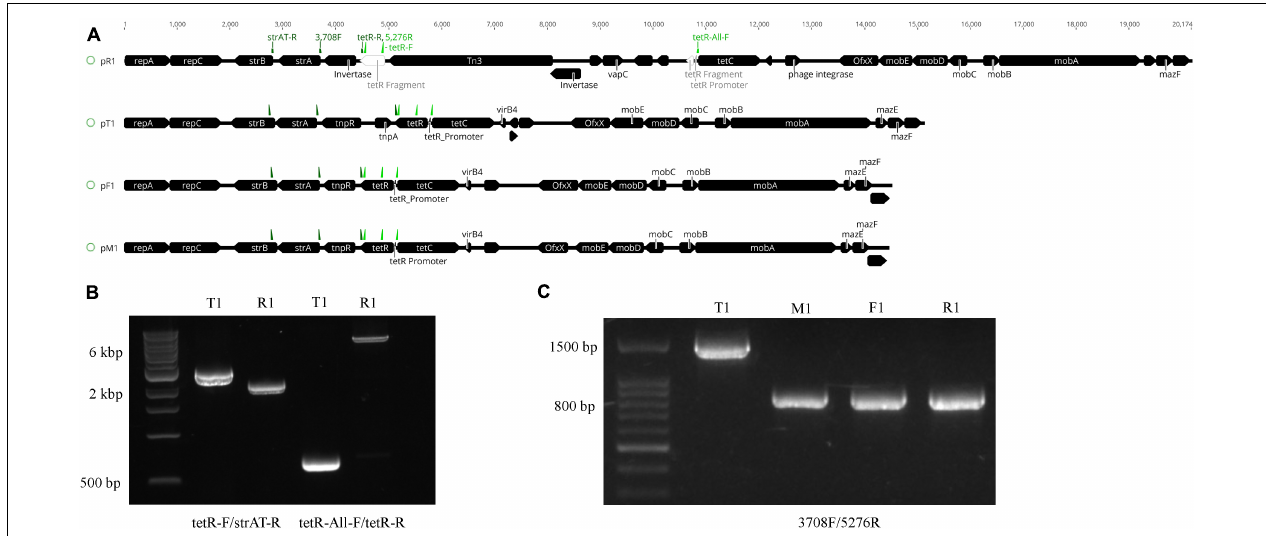
FIGURE 3 | Structural variations of the plasmids harboring the oxytetracycline (OTC) and streptomycin (STR) resistance genes in Xanthomonas arboricola pv. pruni . (A) Linear plasmid map of the de novo assembled plasmids harboring the tetracycline efflux gene tetC , the OTC transcriptional repressor tetR , and the streptomycin resistance operon strAB . The black boxes indicate genes with the points denoting their directions. tetR in strain R1 was physically separated into two parts, bases 1–136 and 137–639, via the Tn 3 insertion. On each plasmid, primers strAT-R, 3708F, and tetR-R were labeled as dark green arrows from left to right, and primers tetR-F, 5276R, and tetR-All-F were labeled as light green arrows from left to right. (B) PCR products of DNA from strains T1 and R1 amplified with the primers tetR-F/strAT-R and tetR-All-F/tetR-R. The amplicon sizes are 2,809, 2,109, 699, and 6,969 bp from left to right. The 1 kb Extend DNA ladder (New England Biolabs) was used in the gel. (C) PCR products of T1, M1, F1, and R1 with the 3708F/5276R primers. The amplicon size is 1,568 bp in T1 and 869 bp in the other three strains. The 100 bp ladder (Biotium) was used in the gel. All of the strains tested positive for Xap using the probe-based qPCR assay (Palacio-Bielsa et al., 2011).